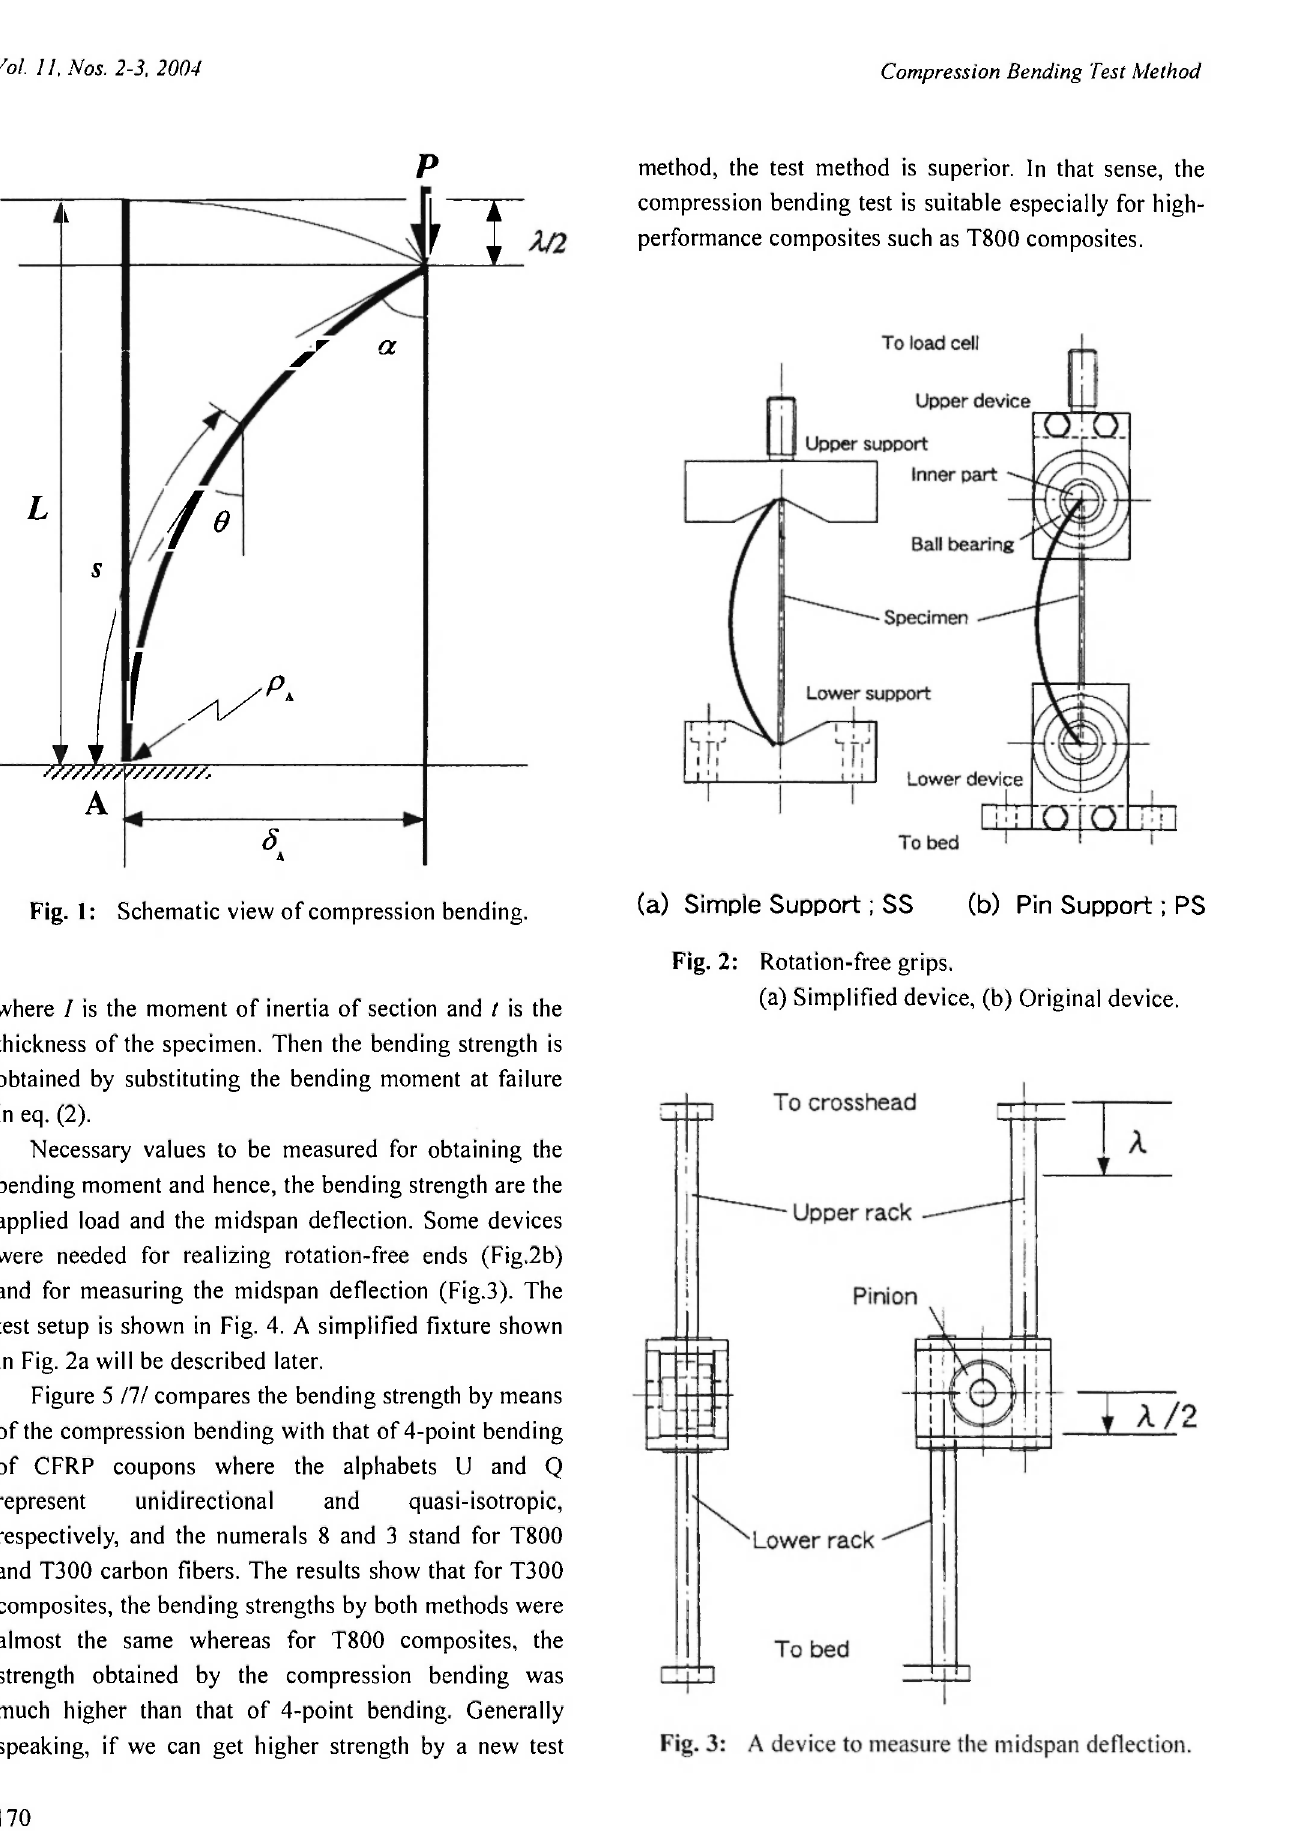
Fig. 2: Rotation-free